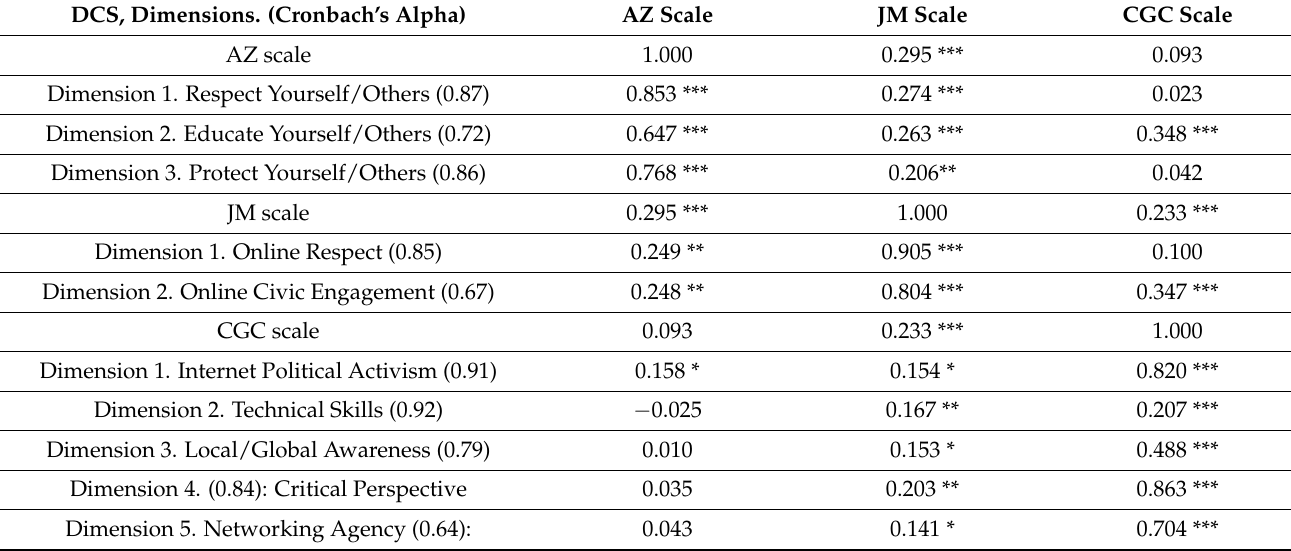
Table 5. Correlations among the different dimensions of the CD scales.